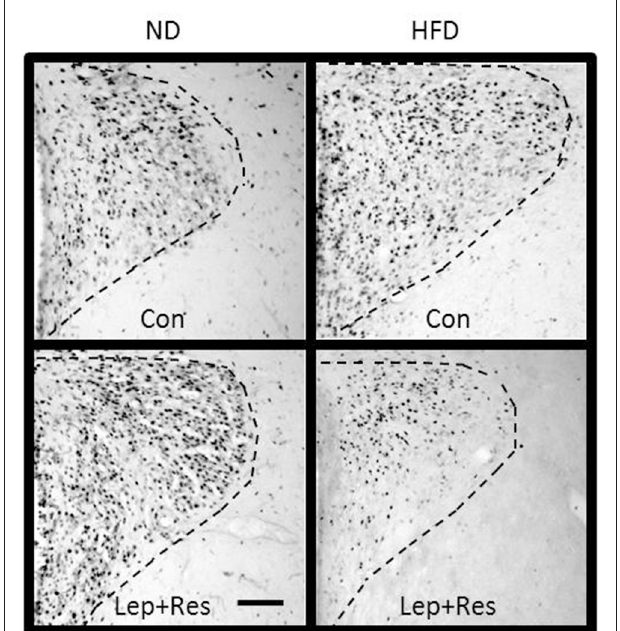
FIGURE 9 | Photomicrographs showing Fos-positive cell nuclei in the arcuate nucleus (outlined by dashed lines) of rats fed a high fat diet (HFD) and rats fed a normal diet (ND) following centrally administered saline (5 µ l; control) or leptin combined with resistin (7 µ g). Scale bar = 100 µ m. The rostrocaudal levels of the sections counted were at ∼ 1.8–2.0mm caudal of bregma.